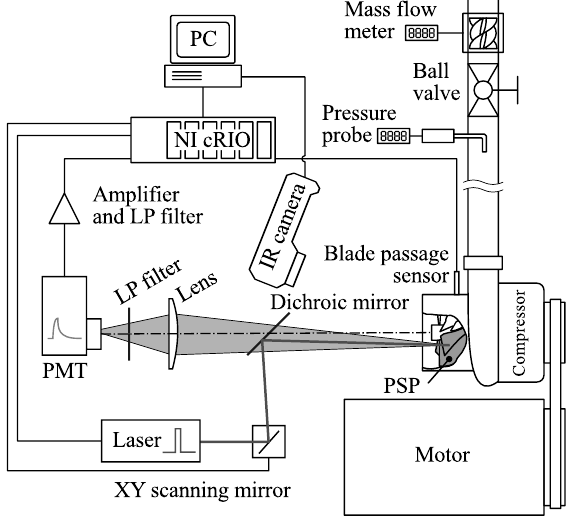
Figure 3. Scanning laser